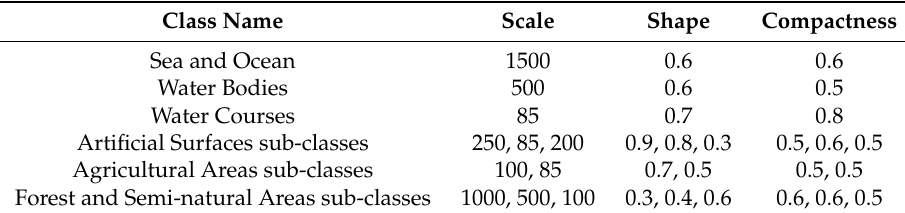
Table 2. Multi-resolution segmentation parameters.